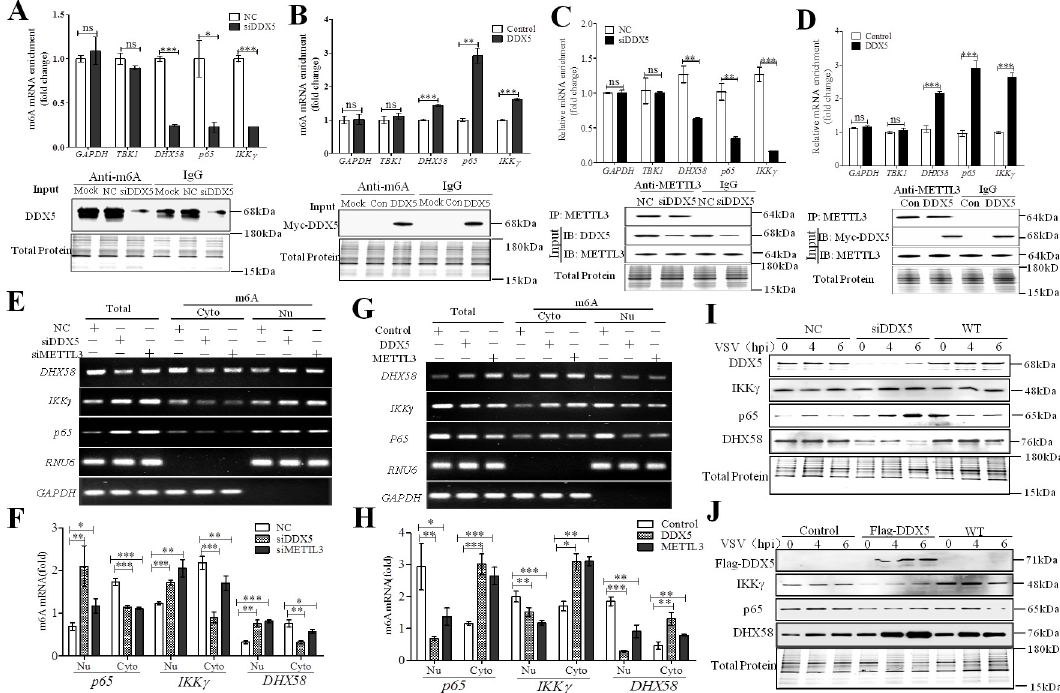
Fig 5. DDX5 regulated transcript expression by promoting nuclear export of m6A-methylated RNAs. (A, B): m6A methylation of transcripts was detected by m6A qRT-PCR in DDX5-knockdown or DDX5 overexpressed MEFs after VSV infection. MEFs were transfected with DDX5 siRNA (siNC) for 48hand infected with VSV for 6h (A), and MEFs were transfected with Myc-DDX5 expressed vector (DDX5) or Myc tag control vector (Con) for 24h and infected with VSV for 6h (B). After extracting total RNA, purifying mRNA, and removing ribosomal RNA, purified mRNA was fragmented and incubated with anti-rabbit m6A or anti-rabbit IgG-conjugated dynabeads for 4h. RNA was isolated from the solution with phenol-chloroform, and cDNA was subjected to qRT-PCR using GAPDH, TBK1, DHX58, IKK γ , and p65 primers. Results are presented relative to those obtained with NC or control groups, and the expression of all the indicated proteins was analyzed using western blotting. (C, D): The interaction between METTL3 and transcripts was detected through METTL3 RIP qRT-PCR in knockdown-DDX5 (C) or DDX5-expressing (D) MEFs after VSV infection. MEFs were transfected with DDX5 siRNA (siNC) for 48 h and infected with VSV for 6 h (C), and transfected with DDX5 expression plasmid (DDX5) or control vector (Con) for 24 h, infected with VSV for 6h, and subjected to METTL3 RIP qRT-PCR to detect GAPDH, TBK1, DHX58, IKK γ , and p65. Results are presented relative to those obtained with NC or control groups, and the expression of all the indicated proteins was analyzed using western blotting. (E, F): Nuclear transcript retention increased in DDX5-knockdown MEFs. MEFs were transfected with DDX5 siRNA (siNC), infected with VSV for 8h, and lysed to extract nuclear to cytoplasmic RNA fractions. Then, RNA was used to analyze m6A modified DHX58, IKK γ , and p65 mRNA by m6A qRT-PCR (E) with RNU6 and GAPDH as the nuclear and cytoplasmic controls, respectively. The quantitative distribution of m6A modified DHX58, IKK γ , and p65 mRNAs in DDX5-knockdown MEFs were detected by m6A qRT-PCR (F). (G, H): Nuclear transcript export was increased in DDX5-expressing MEFs. MEFs were transfected with DDX5 expression plasmid (control vector), infected with VSV for 8h, and lysed to extract nuclear or cytoplasmic RNA; then, RNA was used to analyze m6A modified DHX58, IKK γ , and p65 mRNA by m6A qRT-PCR (G), and the quantitative distribution of these mRNAs was detected by m6AqRT-PCR (H). (I, J) : Immunoblot analysis of DHX58, IKK γ , and p65 in DDX5-knockdownMEFs (I) or DDX5-expressing MEFs (J) after infection with VSV at 0, 4, and 6 h. All data are mean ± SEM of biologically independent samples. Data are representative of three independent experiments. ns, no significant difference. � p < 0.05, �� p < 0.01, and ��� p < 0.001 (Student’s t